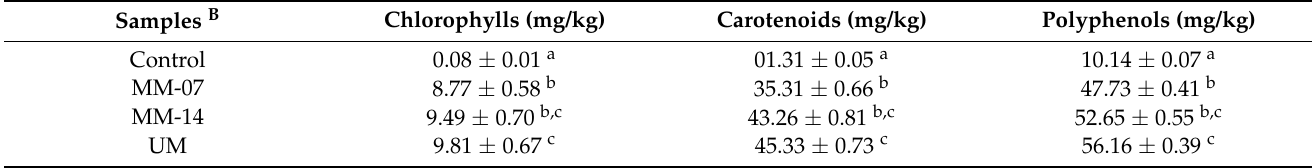
Table 2. The contents of chlorophylls, carotenoids and polyphenols in SFO samples A